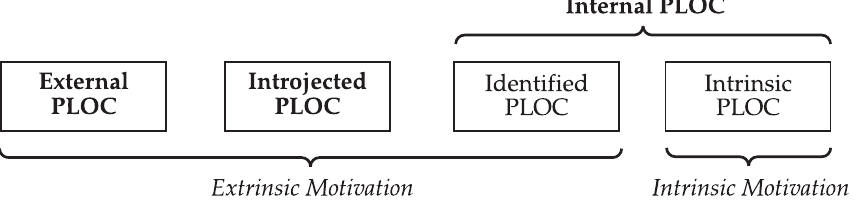
Figure 1. Different types of endogenous motivations and their relations to the PLOC nota- tion (adapted from